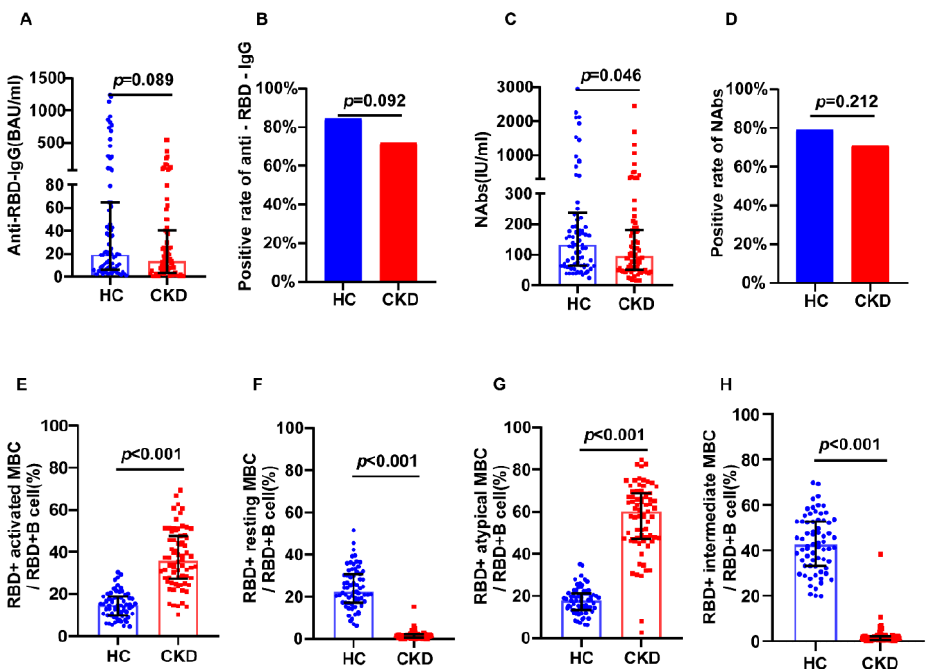
Figure 1. Humoral immune responses following vaccination in CKD patients and healthy controls. ( A ) The serum anti-RBD-IgG levels. ( B ) The seropositivity rates of anti-RBD-IgG. ( C ) The Serum NAbs levels. ( D ) The seropositivity rates of Nabs. ( E ) The frequency (percentage of RBD-specific B cells) of RBD-specific activated MBCs. ( F ) The frequency (percentage of RBD-specific B cells) of RBD-specific resting MBCs. ( G ) The frequency (percentage of RBD-specific B cells) of RBD-specific atypical MBCs. ( H ) The frequency (percentage of RBD-specific B cells) of RBD-specific intermediate MBCs responses. The IQR are indicated by error bars. anti-RBD-IgG, spike receptor-binding domain IgG antibody; CKD chronic renal disease; HC healthy controls; IQR interquartile range; MBCs memory B cells; NAbs neutralizing antibodies.